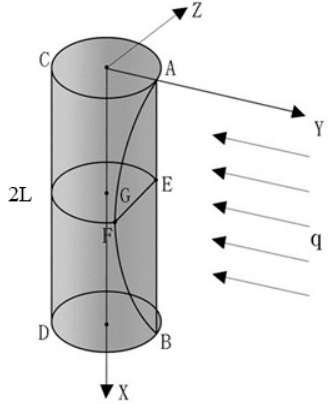
Figure 3. Metal circular tube plastic-deformation mechanics model. Energies 2019 , 12 , x FOR PEER REVIEW